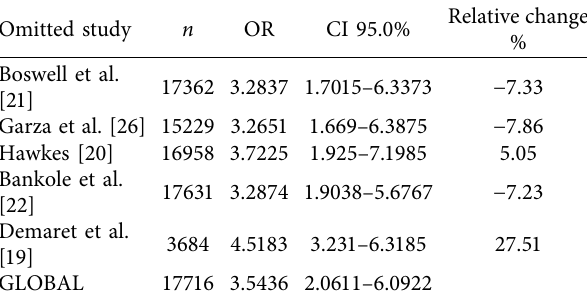
Table 4: Sensitivity